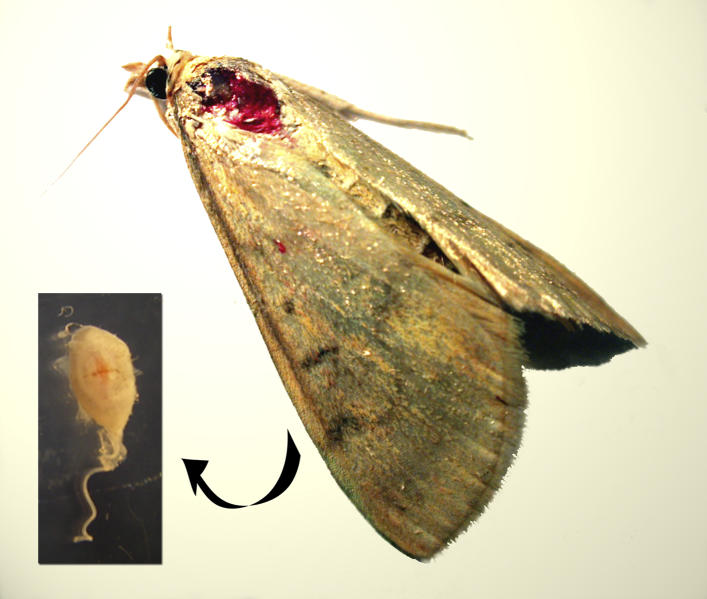
Dispersal and mating patterns in European corn borer moths: a color-marked female and a biogeochemically markedspermatophore (shown at about the same scale). (Image: Dalecky et al., Laurent Pélozuelo, and Laurent Soldati)